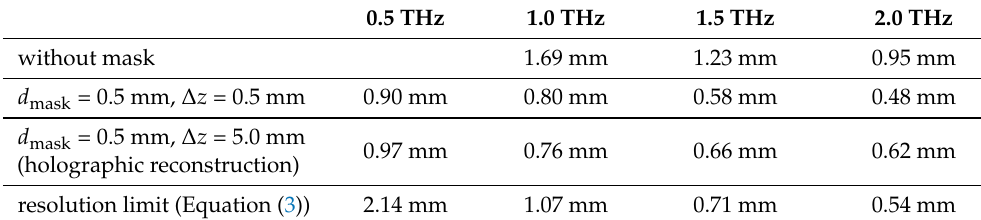
Table 1. Resolutions for selected frequencies compared to resolution limit.